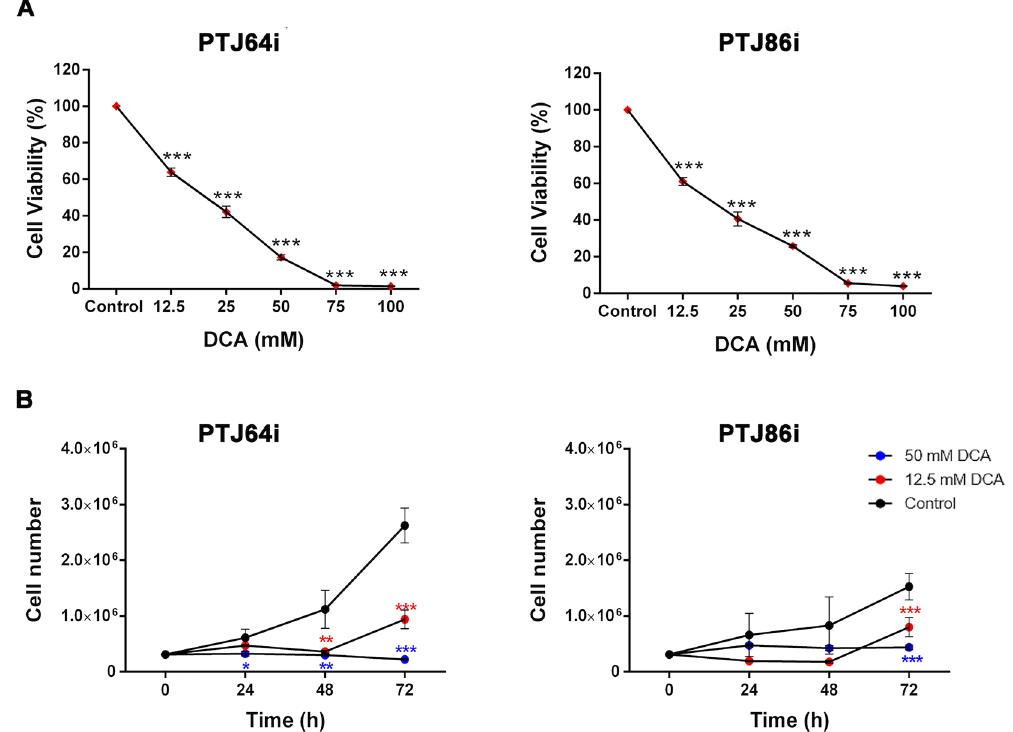
Figure 1. DCA reduces cell viability and growth in PTJ64i and PTJ86i cell lines. (A) Cells were incubated for 72 hours with DCA at the indicated concentrations, or with PBS vehicle (control). Cell viability was assessed by MTT assay. DCA significantly inhibited cell viability in both cell lines in a dose–dependent manner, with an IC 50 of 18.9 mM in PTJ64i and 18.8 mM in PTJ86i, as assessed by CompuSyn. Data shown are the means ± SD of three independent experiments with quintuplicate determinations. * Statistically significant differences between control and each drug concentration ( *** p < 0.001); (B) Cell number was measured over a 72–hour time course treatment with 12.5 mM, 50 mM DCA or with vehicle control. Data shown are the means ± SD of three to nine independent determinations ( * p < 0.05; ** p < 0.01; *** p <